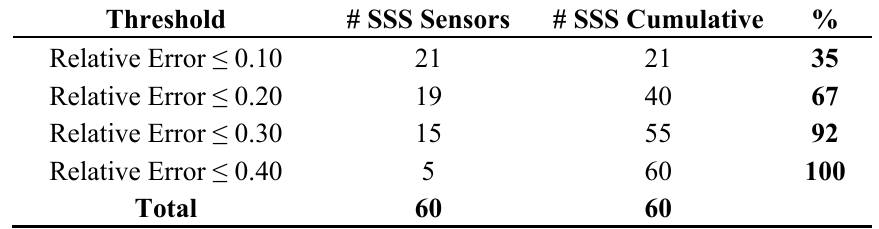
Table 9. Partition of USGS storm surge sensor (SSS) vs. SLOSH relative errors.